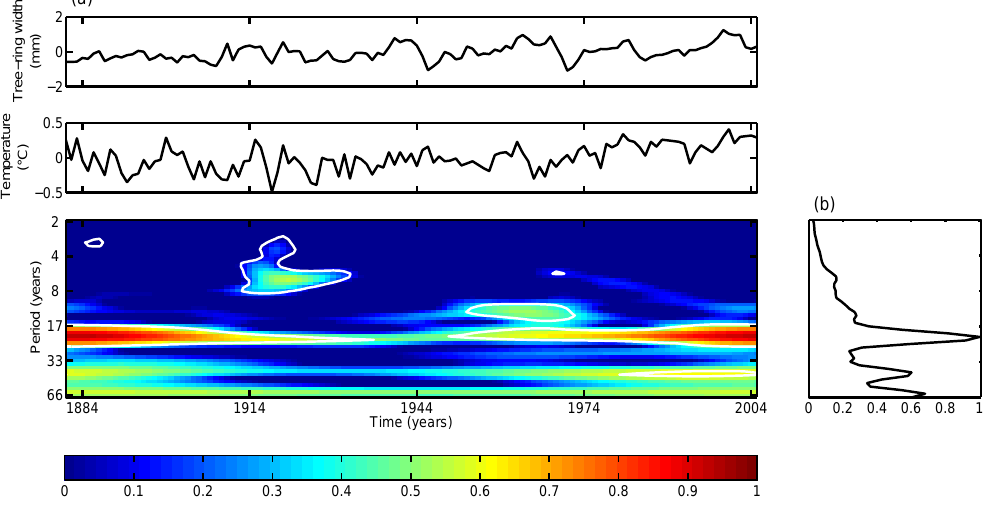
Figure 6. Morlet cross-wavelet map between the annual mean temperature anomaly, between 24 and 44 ◦ S, and the tree-ring average chronol- ogy. The contour plot represents the significance levels for 95%. Panel (b) presents the global wavelet spectrum, which is defined as the wavelet coefficients power average for each scale, i.e., it corresponds to a Fourier spectrum.